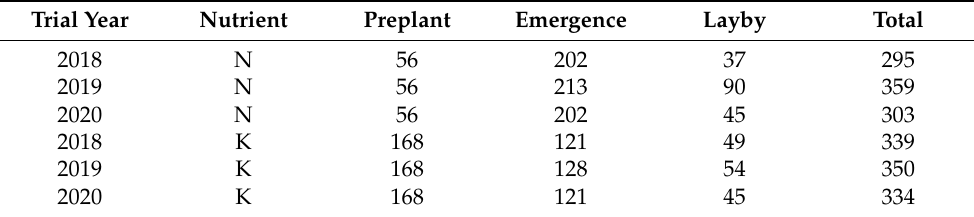
Table 2. Fertilizer (N and K only) rates (kg ha − 1 ) at Farm “B” for each of the three